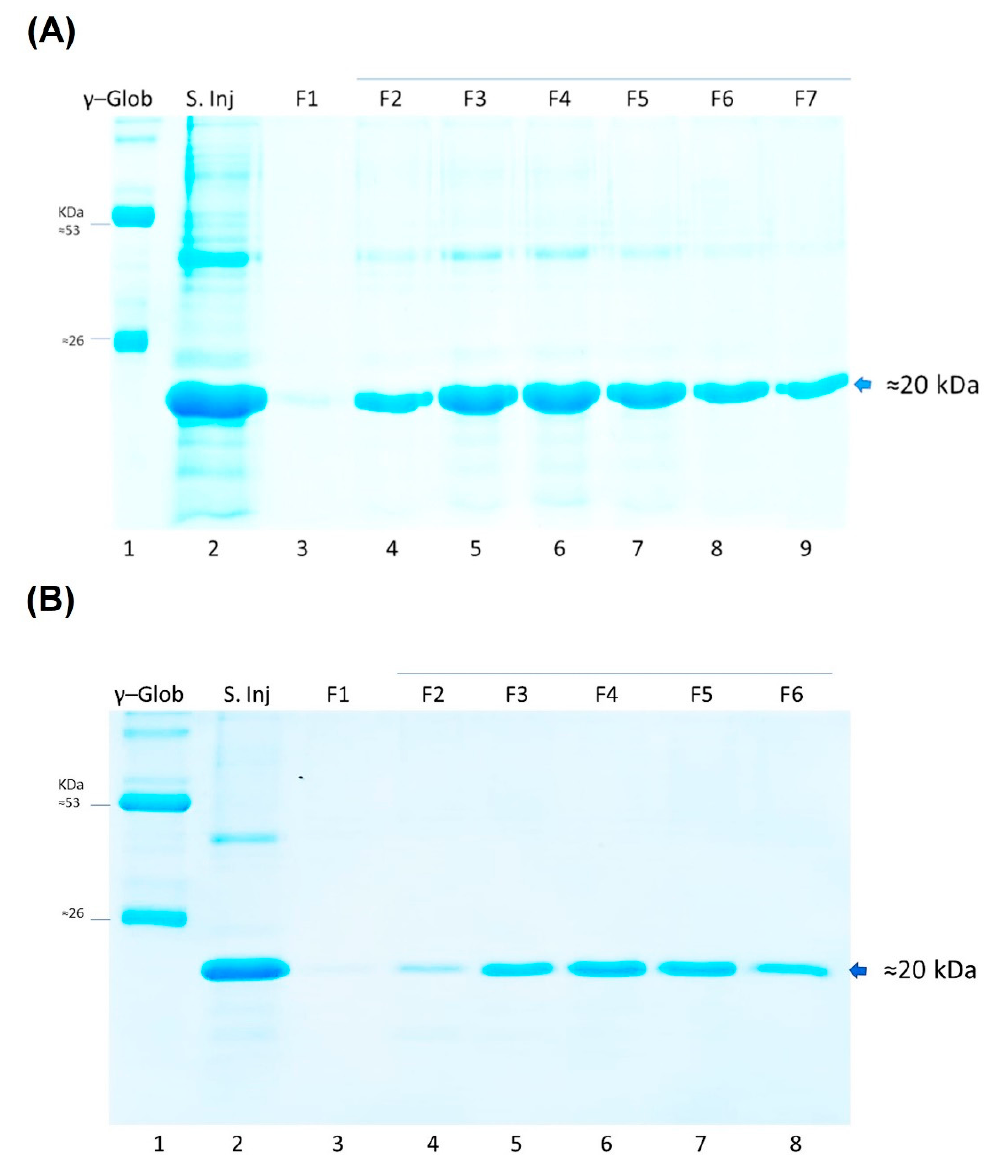
Figure 8. ( A ) SDS-PAGE analysis of eluted fractions during IMAC purification of LTB-RBD delta variant. Lane 1: γ globulin from human blood as molecular weight marker, lane 2: sample injected into IMAC column, and lanes 3 to 9: eluted fractions upon entrance of imidazole for protein desorption. ( B ) SDS-PAGE analysis of elution fractions during anionic exchange chromatography. Lane 1: γ globulin from human blood as molecular weight marker, lane 2: sample injected into anionic column, and lanes 3 to 8: eluted fractions upon entrance of NaCl for protein desorption.